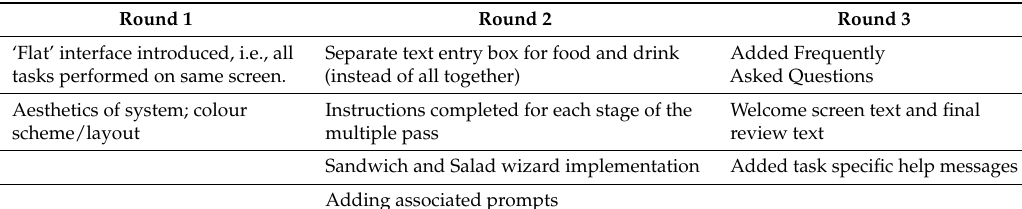
Table 1. Summary of modifications throughout system development, after user